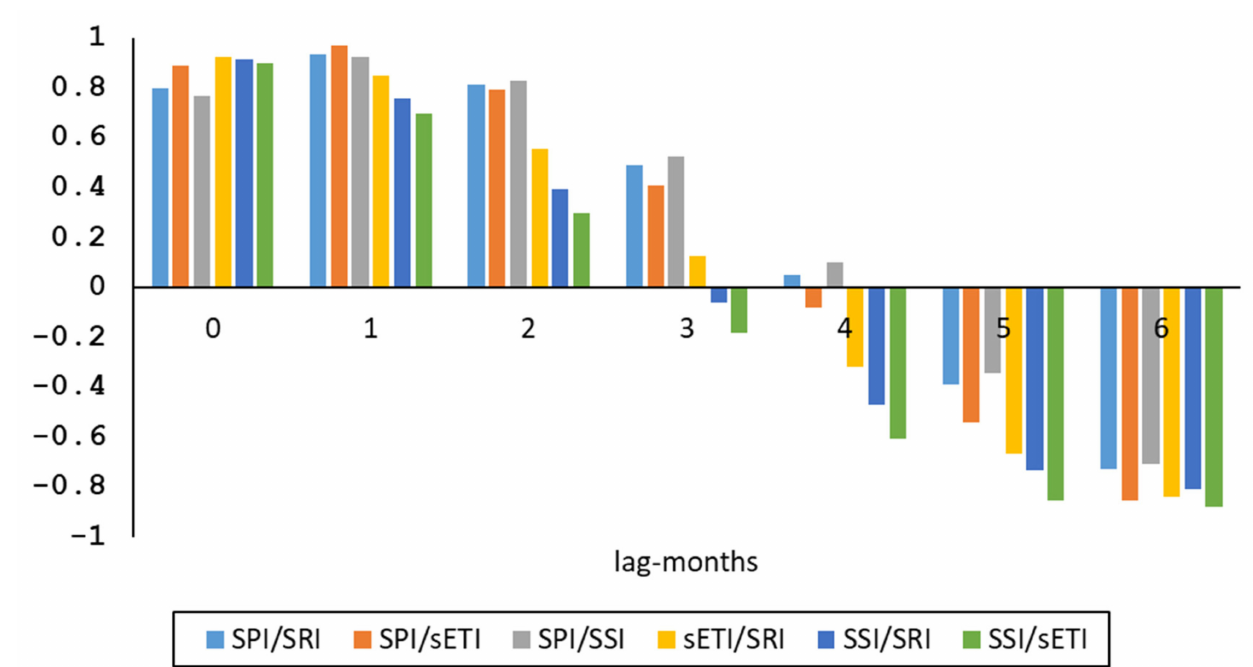
Figure 14. Correlation results among indices of 3-month accumulation period with a time lag up to 6 months.